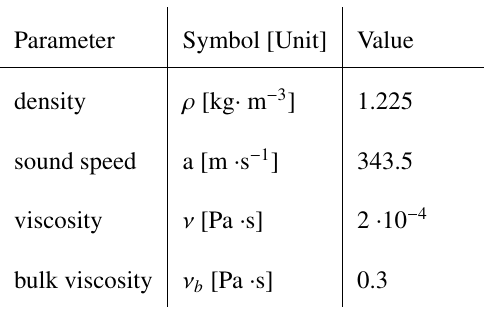
Table 2. Simulation parameter settings .